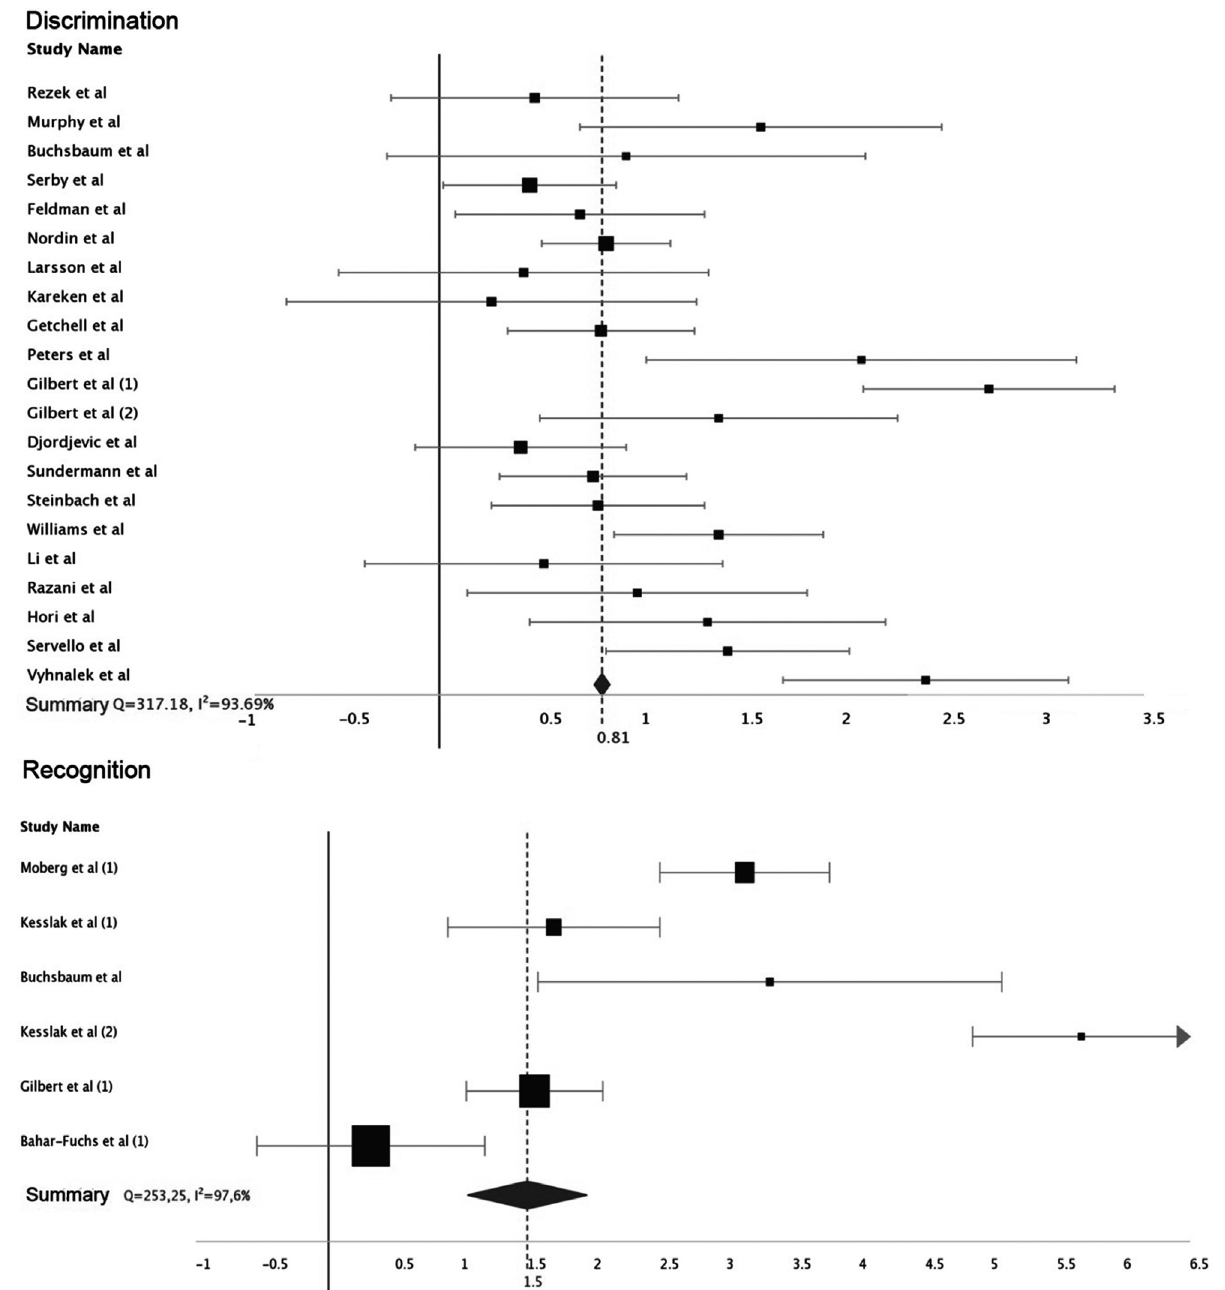
Figure 3. Individual study effect sizes: discrimination and recognition